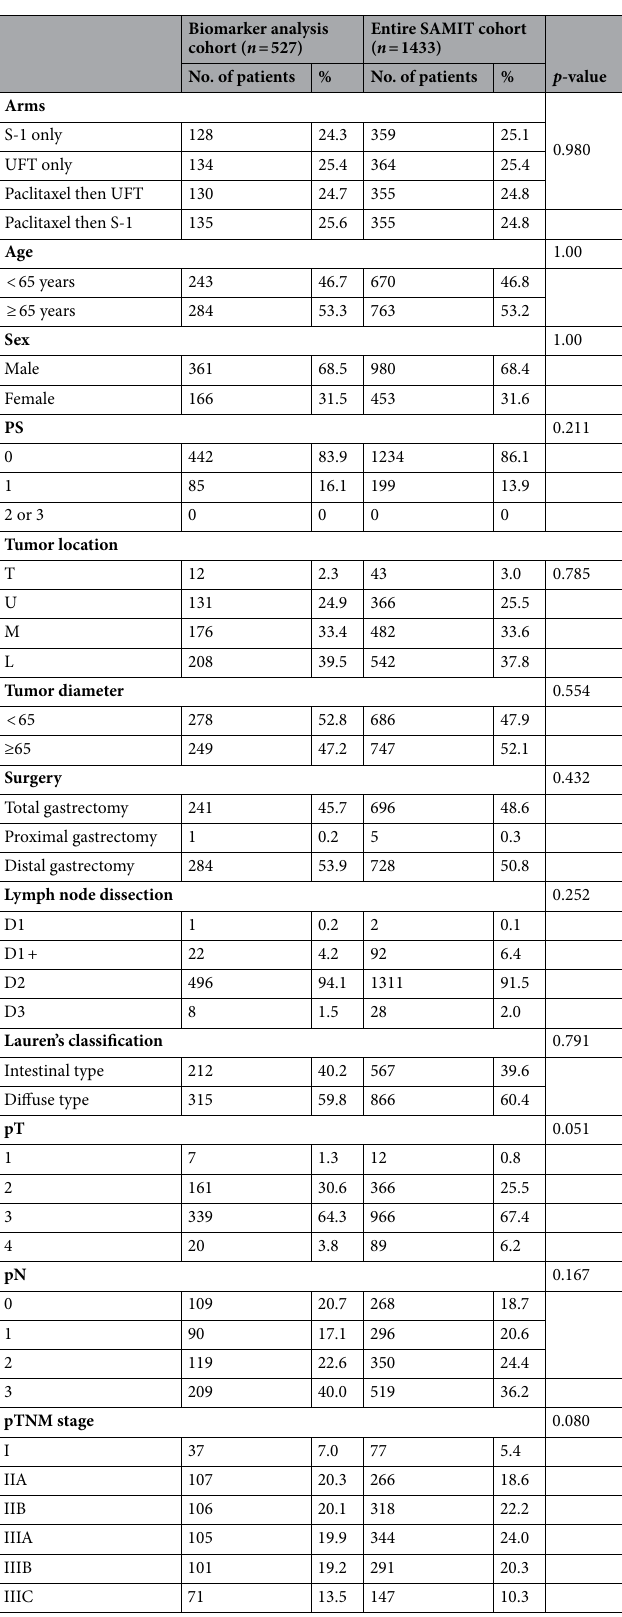
Table 1. Clinical and pathological characteristics of patients included in the biomarker analysis compared to the entire SAMIT patient cohort. UFT tegafur/uracil, T total stomach, U upper third of stomach, M medium third of stomach, D distal third of stomach, T pathological tumor depth, pN pathological lymph node metastasis, M distant metastasis, PS performance